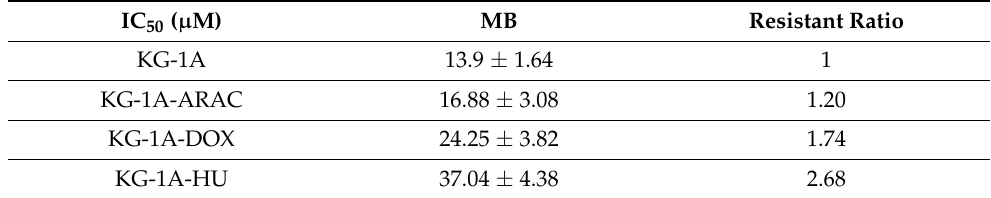
Table 3. Statistics of MTT IC 50